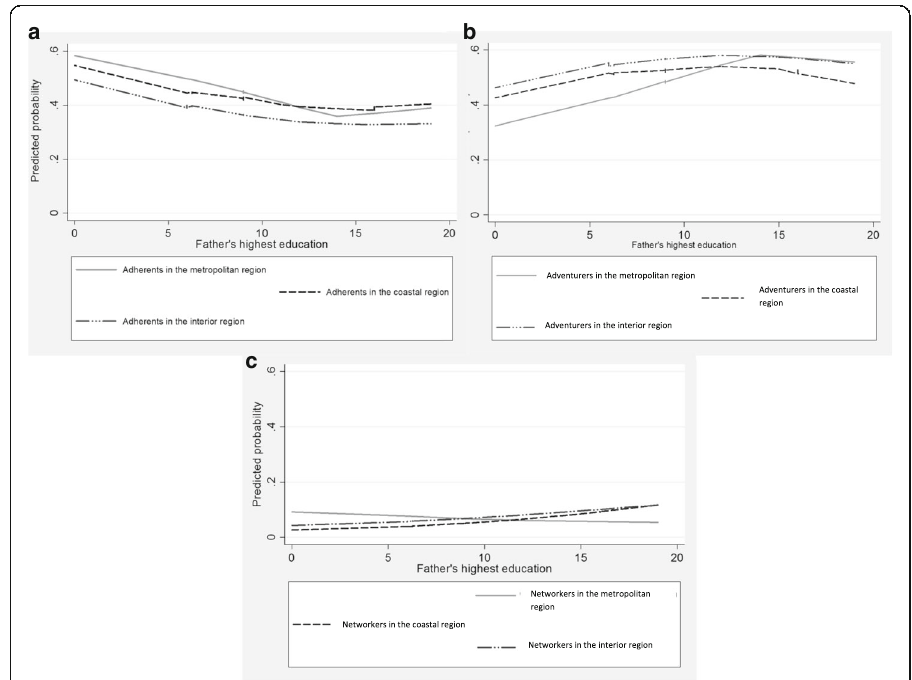
Fig. 7 a – c Predicted probabilities of three types of successful job seekers by father ’ s education and region — X- axis measures education by years, and Y-axis measures probabilities (between 0 and 1); the long-dash-dot-dot-dot line indicates the interior region, the short-dash line indicates the coastal region, and the solid line indicates the metropolitan region. a The predicted probability of being adherents in three regions. b The predicted probability of being adventurers in three regions. c The predicted probability of being networkers in three